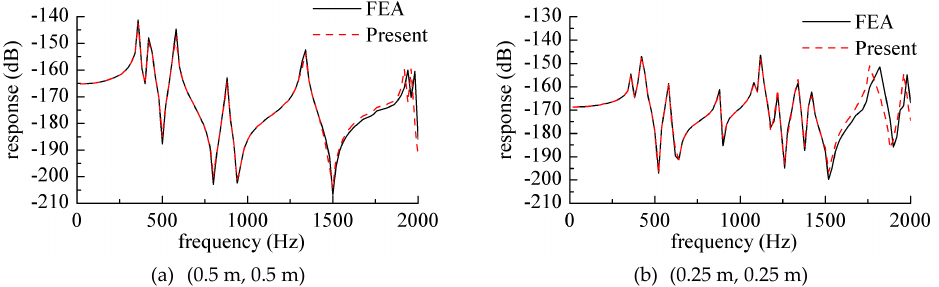
Figure 13. Response curve while the harmonic force acted on various positions of the cantilever plate. ( a ) (0.5 m, 0.5 m), ( b ) (0.25 m, 0.25 m). ( a ) (0.5 m, 0.5 m), ( b ) (0.25 m, 0.25 m).